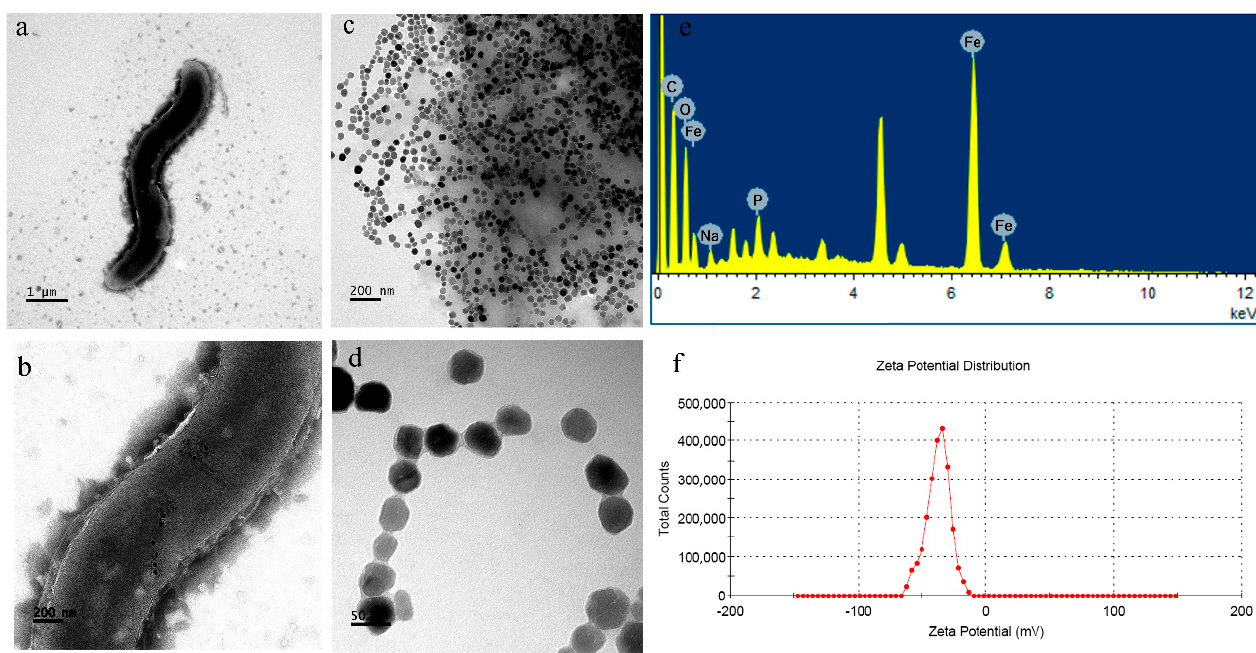
Figure 3. Characterization of magnetosomes. ( a , b ) TEM images of Magnetospirillum magneticum , scale bars of ( a ) 1 μ m, and ( b ) 200 nm, ( c , d ) TEM images of purified magnetosomes, scale bars of ( c ) 200 nm, and ( d ) 50 nm, ( e ) EDS spectra showing the elemental composition of magnetosomes, and ( f ) zeta potential distribution of magnetosomes dispersed in water.